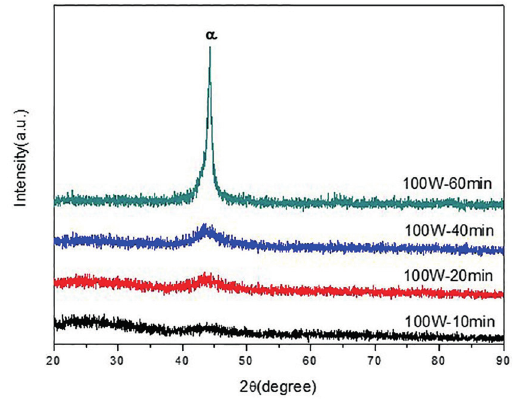
Figure 2: X-Ray diffraction curves of the coatings at different time under 100W plasma power.